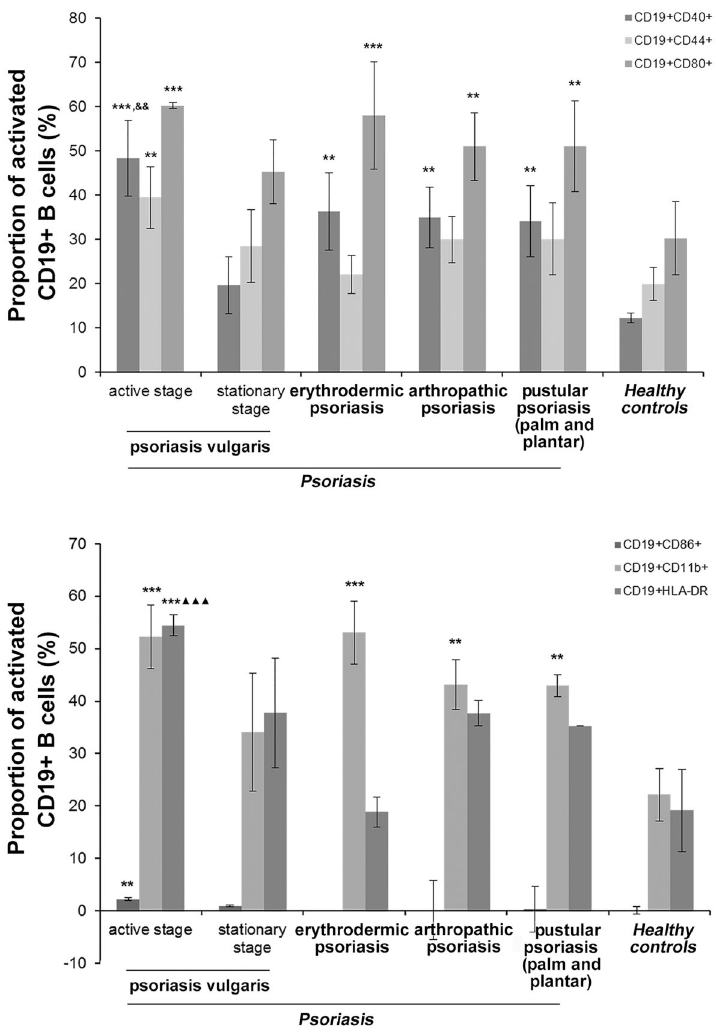
Figure 3. Proportion of CD19 + B cells surface activation markers in peripheral blood mononu- clear cells, determined by fl ow cytometry. **P o 0.01, ***P o 0.001 vs healthy controls; && P o 0.05 vs pso- riasis vulgaris at the stationary stage; mm P o 0.01, mmm P o 0.001 vs erythrodermic psoriasis. Data are reported as means ± SD (n=33 for psoriasis vulgaris at the active stage; n=32 for psoriasis vulgaris at the stationary stage; n=32 for erythro- dermic psoriasis; n=30 for arthropathic psoriasis; n=30 for pustular psoriasis (palm and plantar); n=35 for healthy controls). Statistical analysis was performed with one-way analysis of